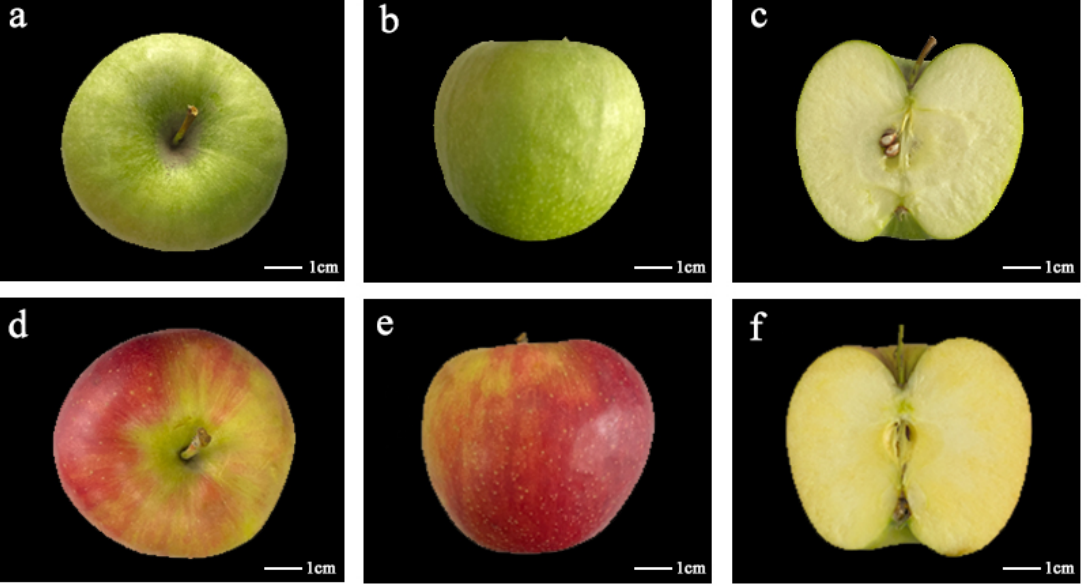
Figure 1. Phenotypes of Granny Smith and Jonagold apples. ( a – c ) Phenotype of the Granny Smith apple. ( d – f ) Phenotype of the Jonagold apple. Table 1. Physiological traits of Granny Smith and Jonagold apples.